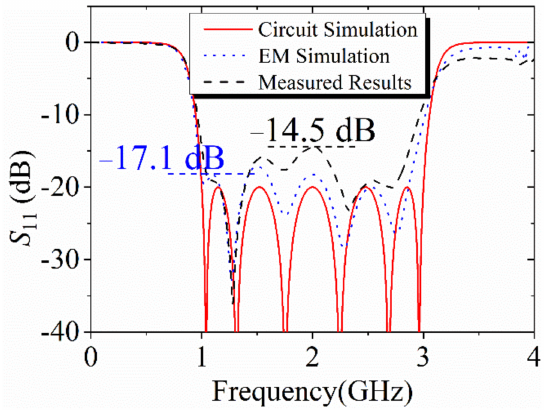
Figure 13. Circuit simulation, EM simulation and measured